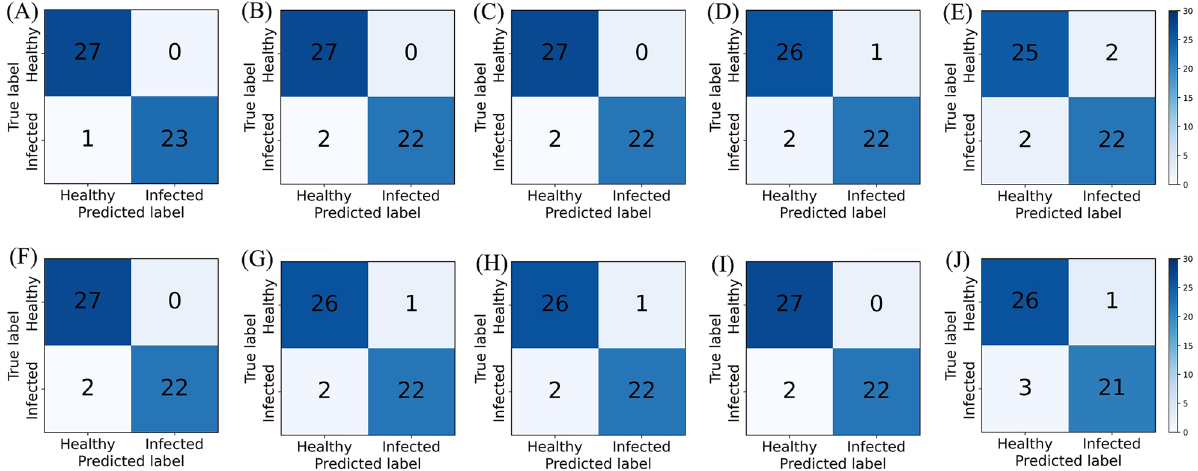
Figure 4. Confusion matrices of the PLS-DA and SVM models with different preprocessing methods. ( A ) RAW-PLS-DA. ( B ) FD-PLS-DA. ( C ) SD-PLS-DA. ( D ) SNV-PLS-DA. ( E ) MSC-PLS-DA. ( F ) RAW-SVM. ( G )